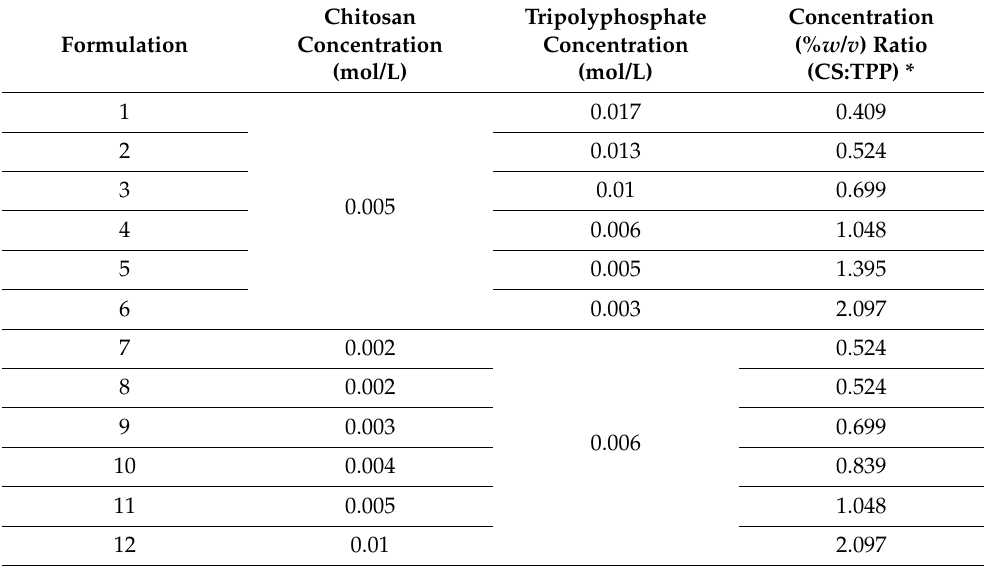
Table 5. Summary of variables applied during the ionic gelation method to investigate the effect of chitosan and tripolyphosphate concentrations on particle size. Chitosan Formulation